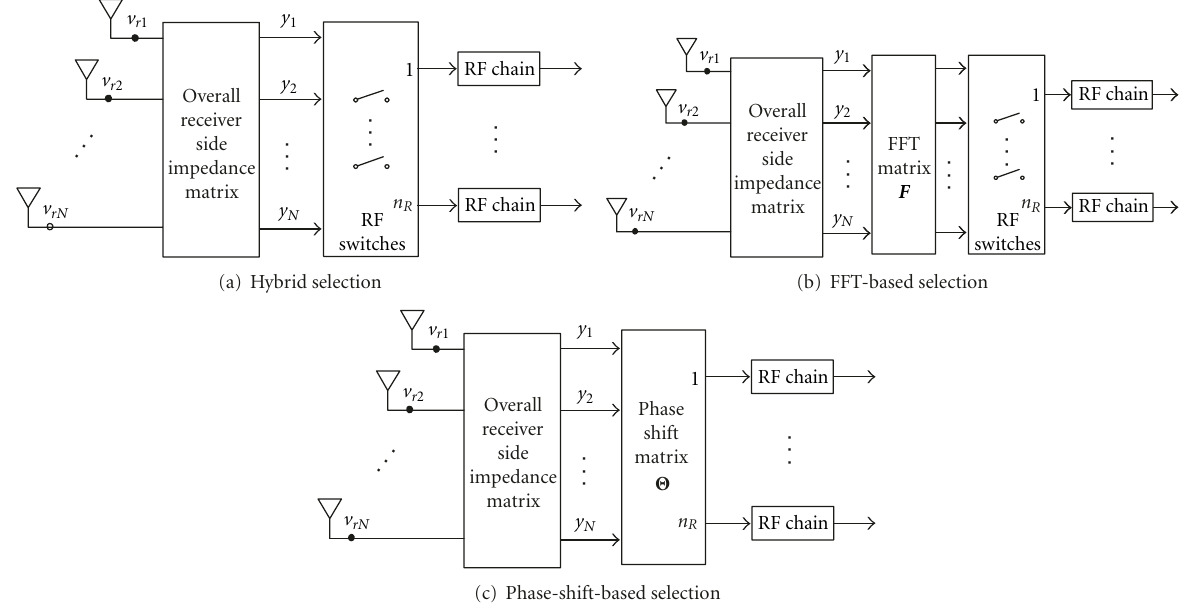
Figure 4: AS at the receiver side for spatial multiplexing